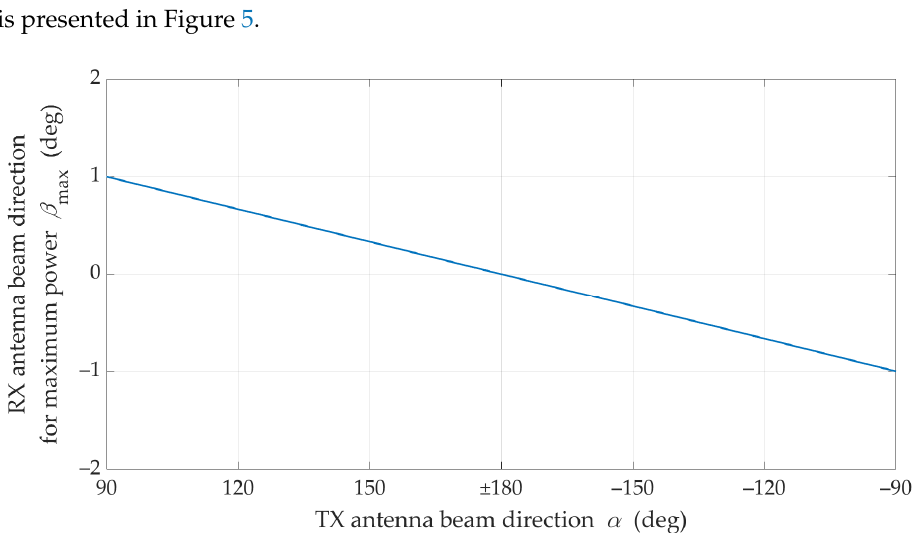
Figure 5. Optimal reception angle for different transmitting beam direction under LOS